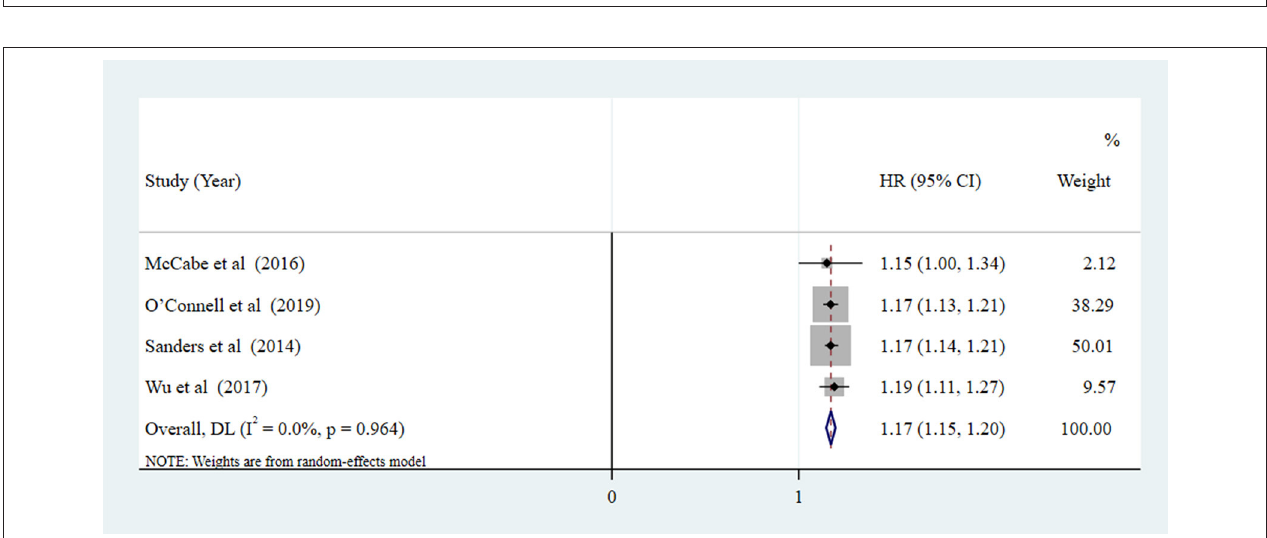
FIGURE 2 | Forest plot of the pooled HR of all-cause mortality risk for SA (SA as a dichotomous variable. NSA as the reference group. SA, successful aging; NSA, non-successful aging; HR, hazard ratio).